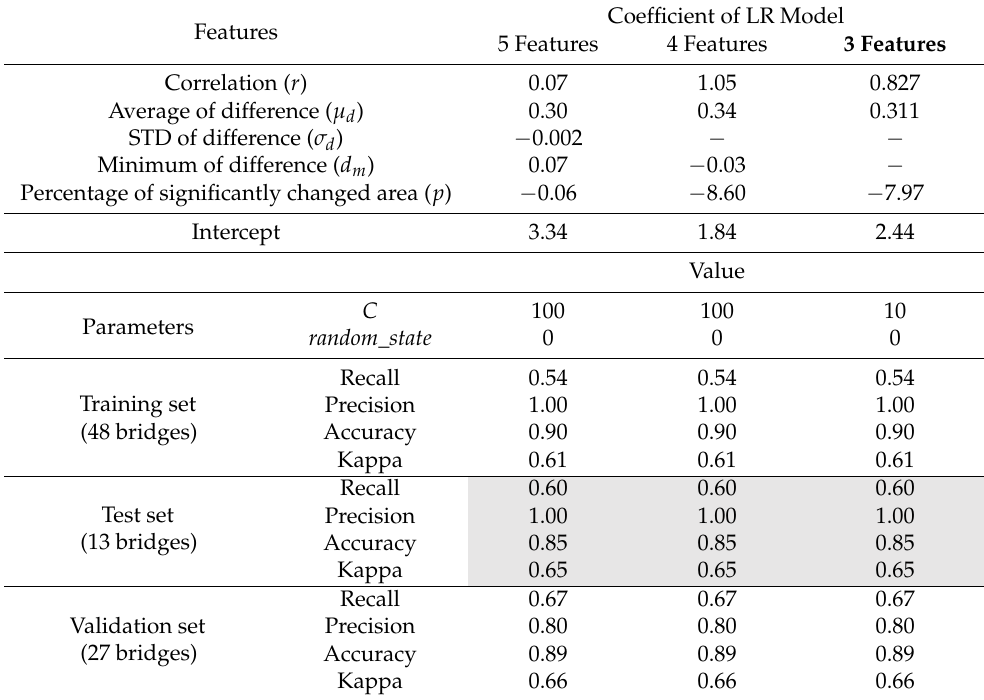
Table 9. Comparison of the LR models using data set 2 with the different numbers of features; the best model is emphasized in bold font. The highest accuracy for the test data is emphasized by the gray